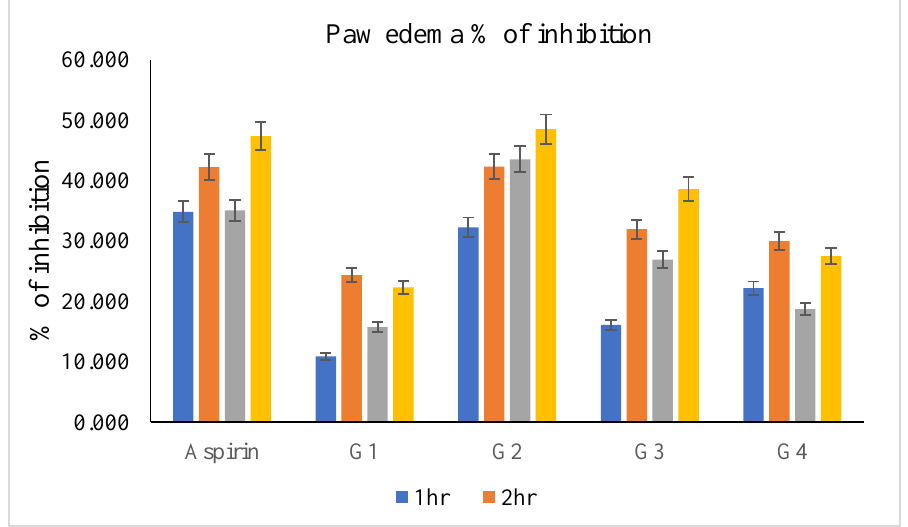
Figure 11. The effect of different treatments on percentage inhibition of edema in carrageenan-induced paw edema.